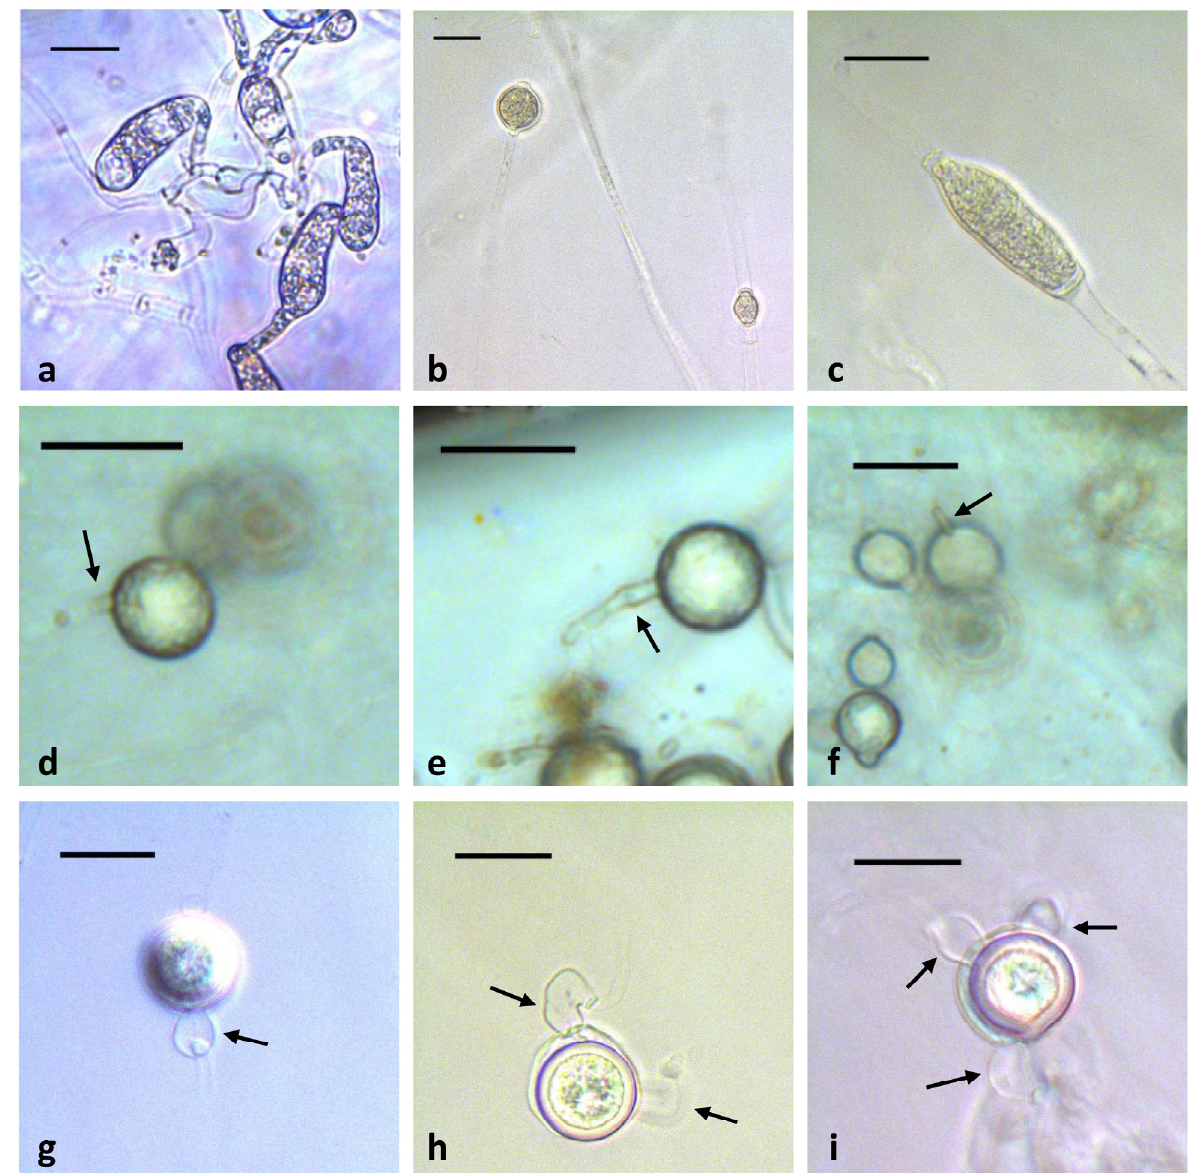
Figure 4. Morphological structures of Globisporangium capense sp. nov. ( a ) Clavate appressoria in chain; ( b ) young globose and doliiform intercalary sporangia; ( c ) young elongate intercalary sporangia; ( d – f ) sporangia with discharge tubes (arrows); ( g ) plerotic oospore with a hypogynous antheridium (arrow); ( h ) aplerotic oospore with two crook-necked antheridia (arrows); ( i ) aplerotic oospore with three antheridia (arrows). Scale bar: 20 µm.